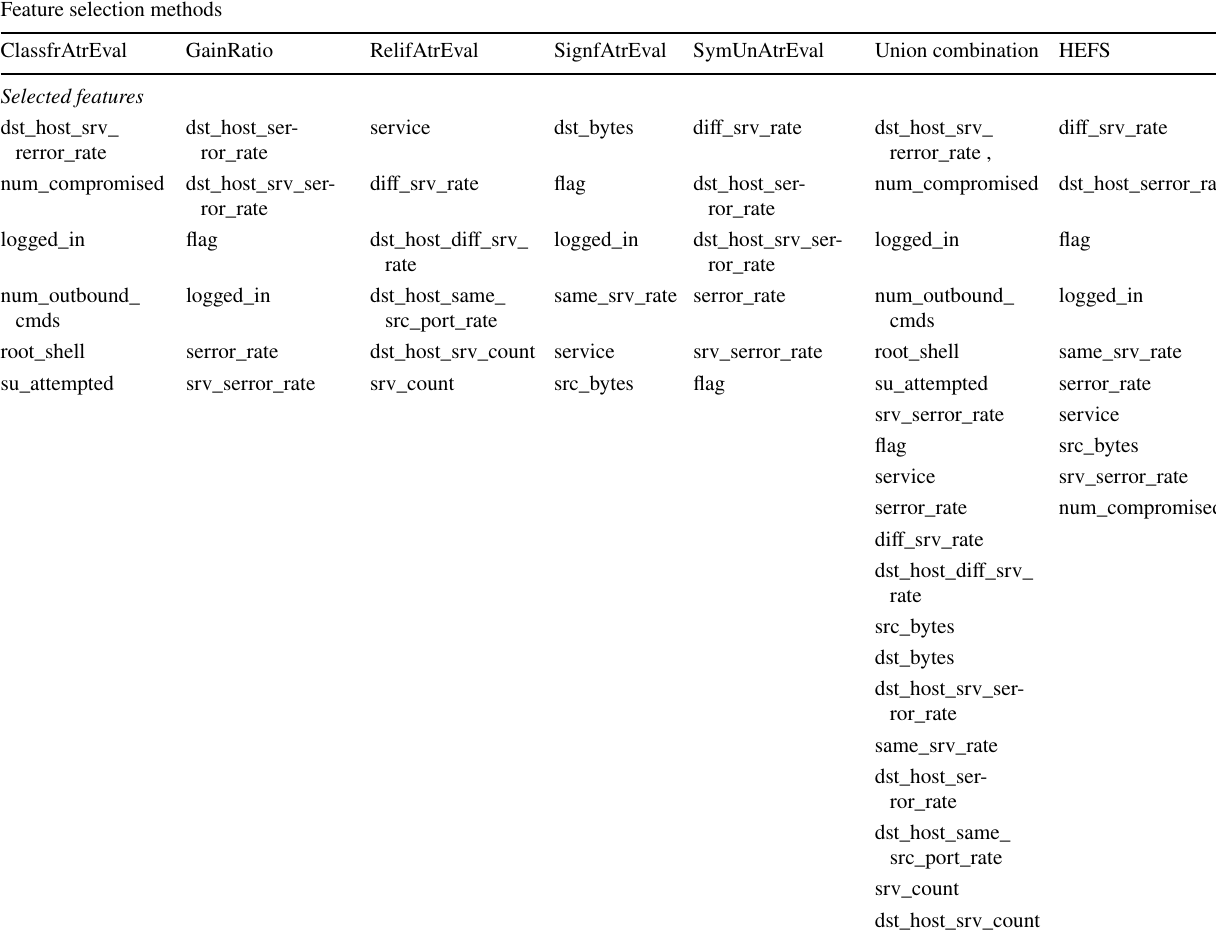
Table 3 The list of selected features with the corresponding feature selection methods Feature selection